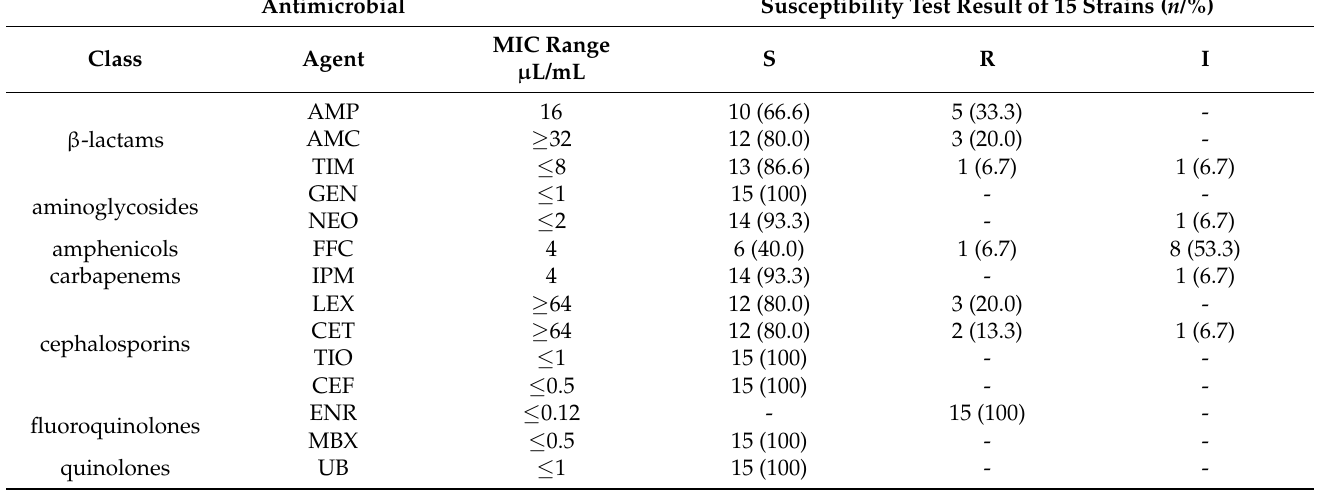
Table 3. Antimicrobial susceptibility profile of the Romanian fresh-cheese-origin E. coli strains tested with the AST-GN96